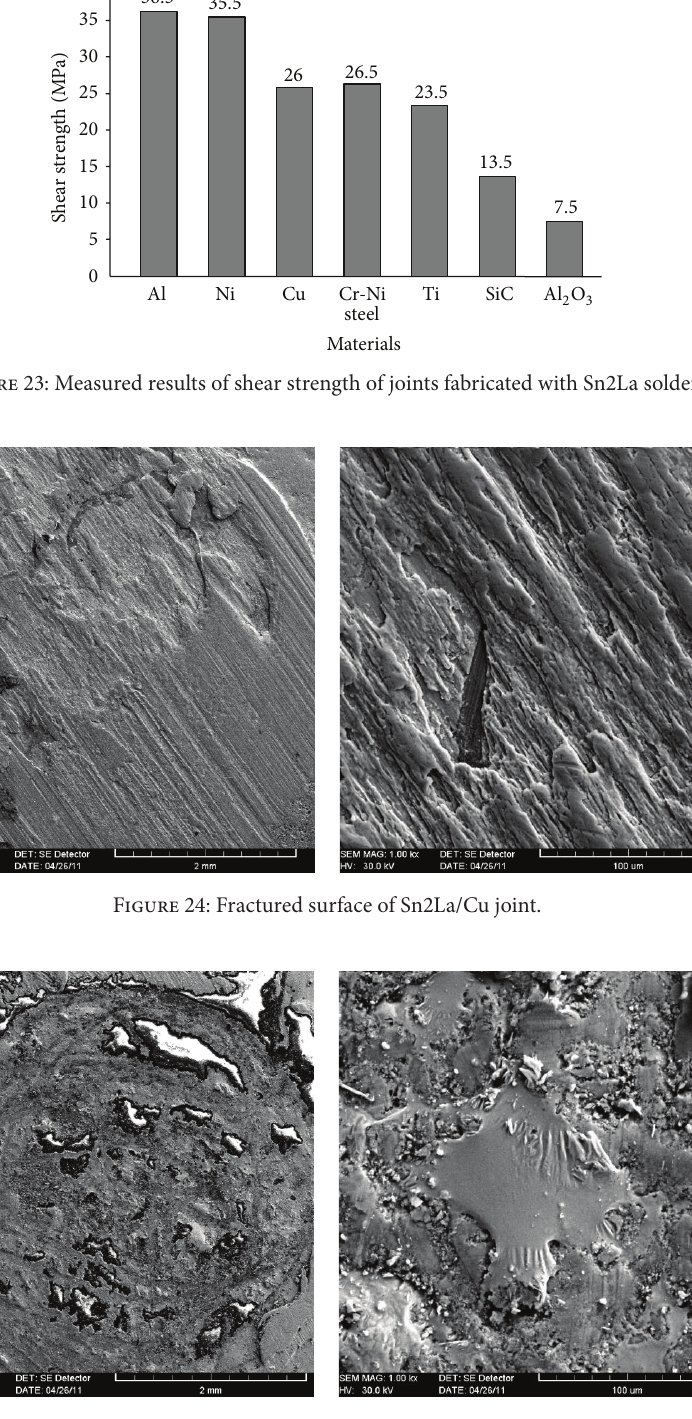
Figure 25: Fractured surface of Sn2La/Al 2 O 3